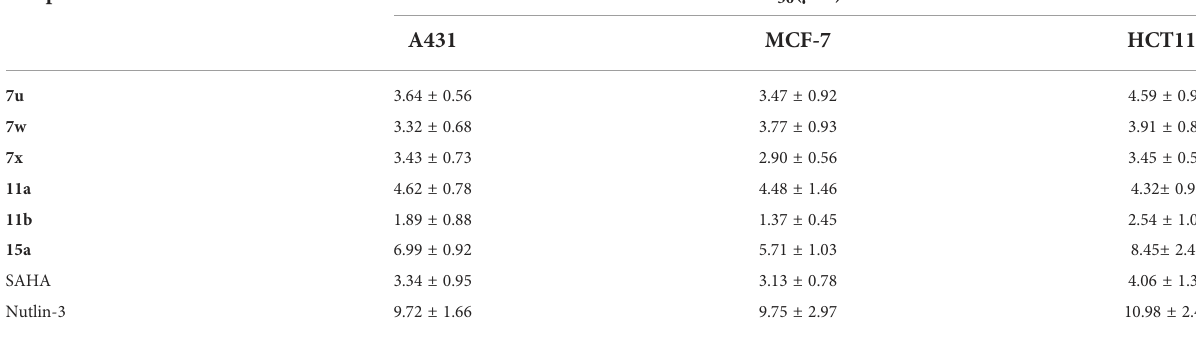
TABLE 5 Antiproliferative activities of compounds 7u , 7w , 7x , 11a , 11b, and 15a